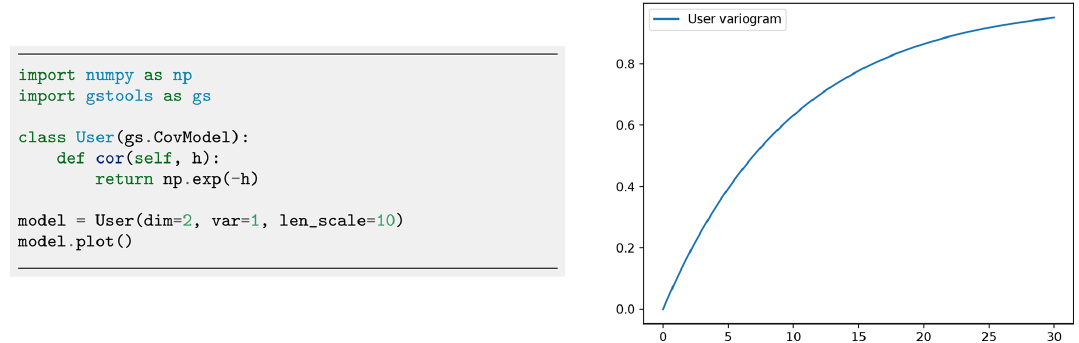
Figure 2. Initialization of a user-defined exponential covariance model. The only thing that needs to be defined is the normalized correlation function cor .